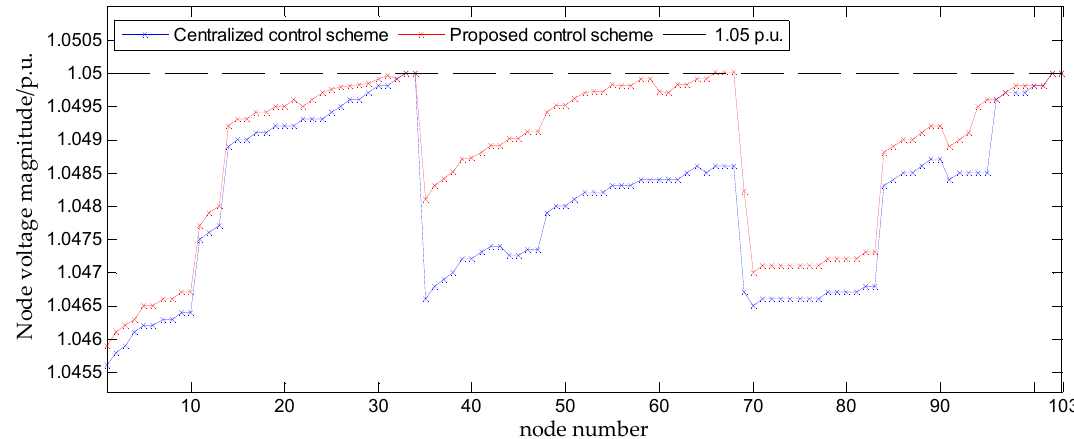
Figure 12. Voltage profiles under the centralized control scheme and the proposed scheme.